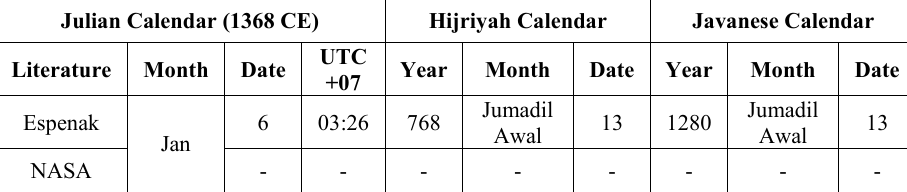
Table 2. Date Conversion from Julian Calendar to Hijriyah Calendar and Javanese Calendar for 1368 CE with Hisab Urfi